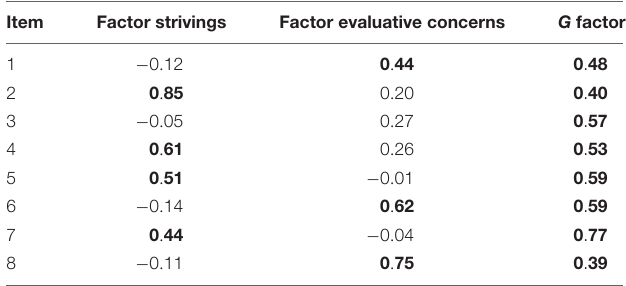
TABLE 4 | Rotated loading matrix in exploratory bifactor model.